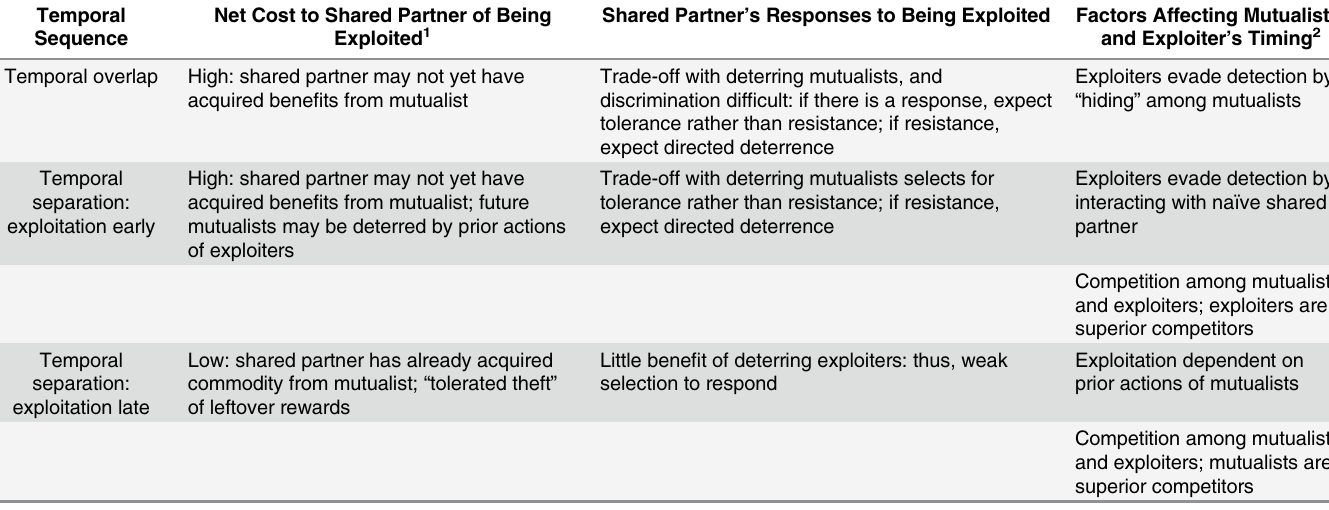
Table 1. Summary of predictions about temporal sequences of exploitation. For each temporal sequence, we predict how the timing of interactions affects the net cost to the shared partner and potential responses by the shared partner as a result of this cost. We also predict selection pressures on the mutualist and exploiter that may cause each type of temporal sequence to